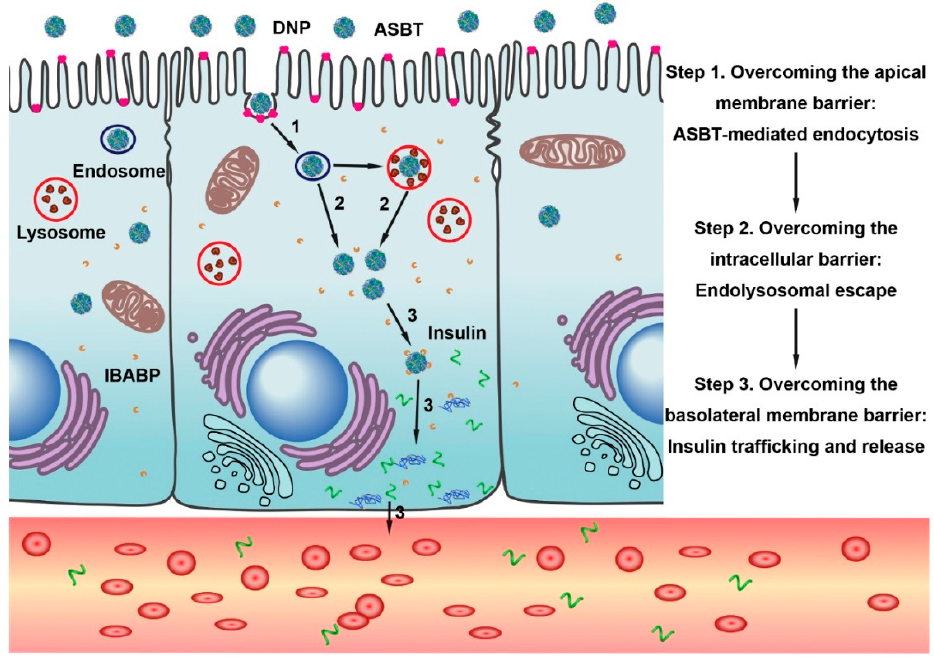
Figure 4. Schematic illustration of insulin-loaded DNPs overcoming multiple barriers of the intestinal epithelium by exploiting the bile acid pathway for enhanced oral absorption. Reproduced with permission from [63]; Copyright 2018 Elsevier Ltd.